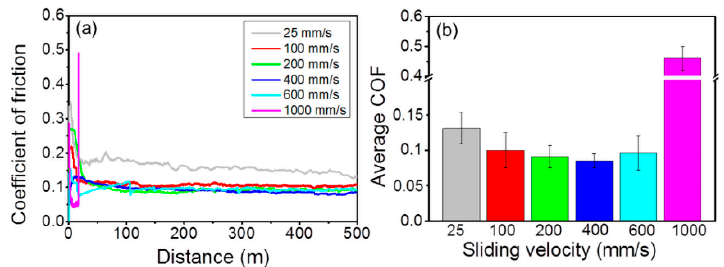
Figure 2. Sliding velocity dependence of friction coefficient on the H-DLC films. ( a ) Friction coefficient curves of the H-DLC film slid against Al 2 O 3 balls under the different sliding velocities. ( b ) The average friction coefficient in the steady stage at each condition calculated from ( a ).